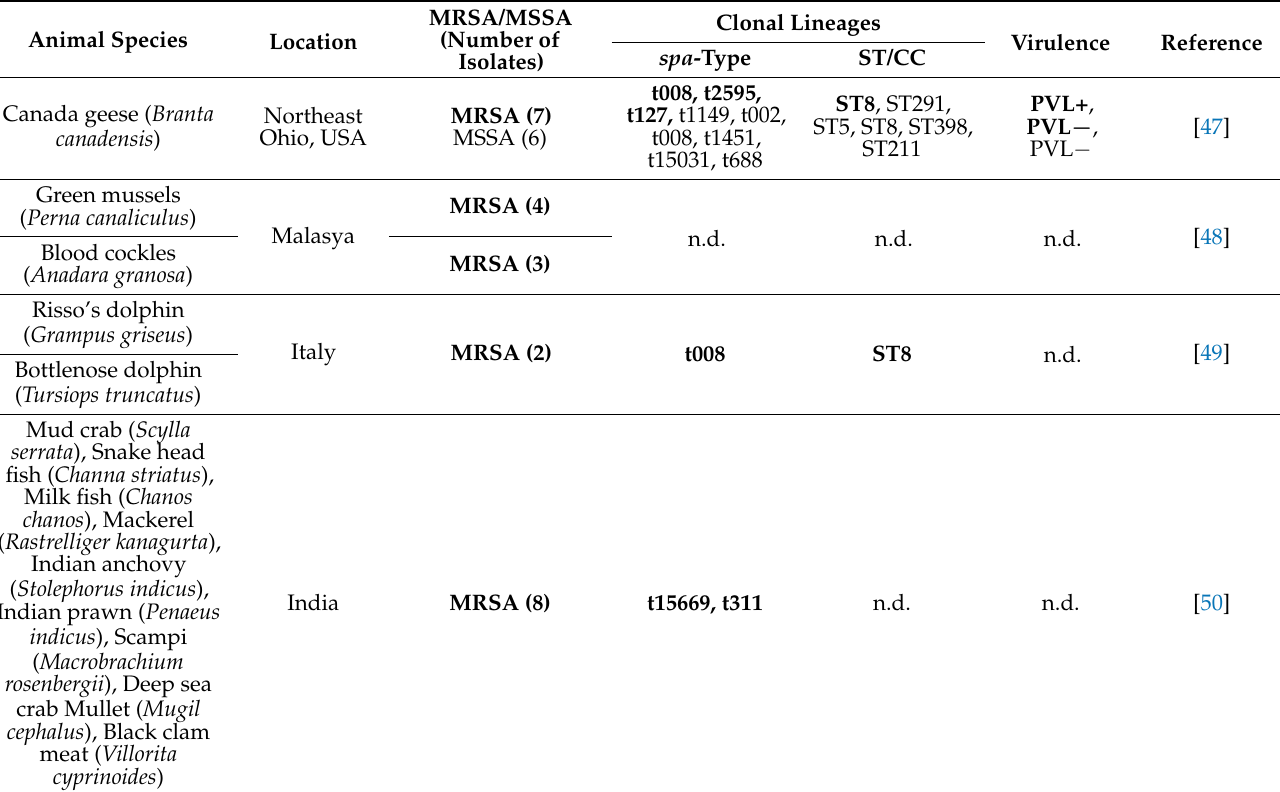
Table 2. Animal species: location of isolation and genetic lineages of MSSA and MRSA isolated from aquatic animals. Animal